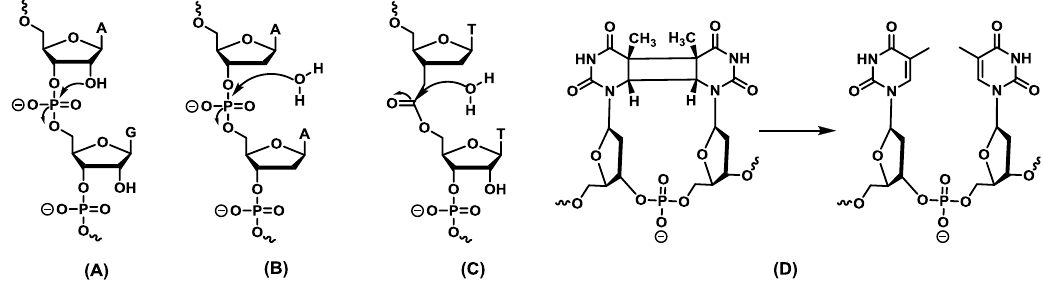
Figure 2. Summary of the different reactions catalyzed by bond-cleaving DNAzymes: ( A ) cleavage of ribophosphodiester linkages; ( B ) scission of deoxyribophosphodiester bonds [48,49]; ( C ) hydrolysis of ester units [50]; ( D ) photoreactivation of cyclobutane thymine dimers [51].